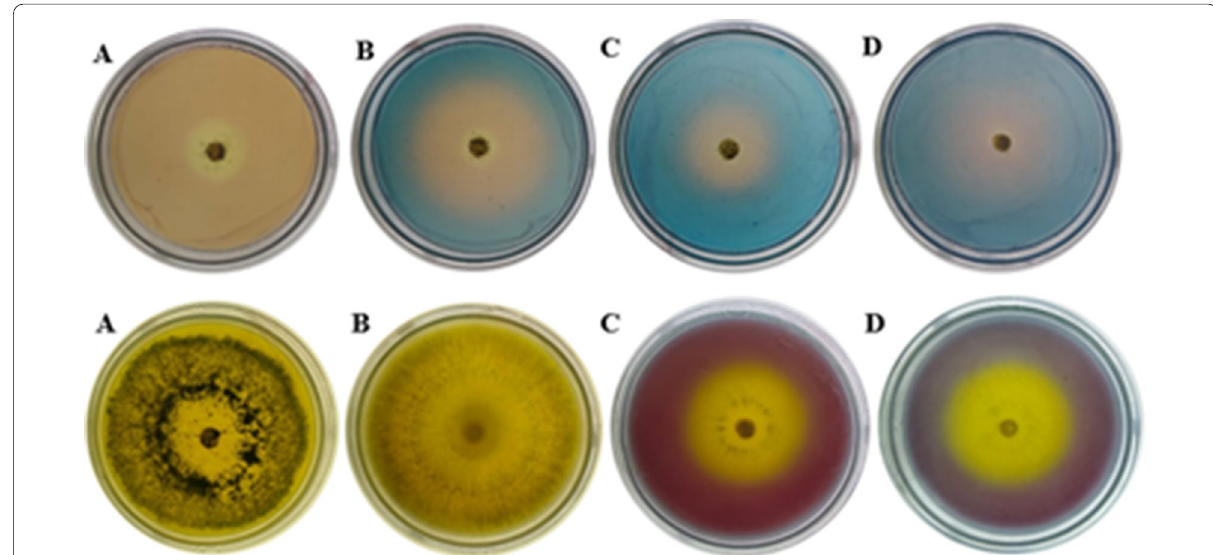
Fig. 4 In vitro plant growth promotion A Trichoderma harzianum , B T. viride , C T. longibrachiatum , D T. asperellum . The first row corresponds to siderophore production; while the second one to phosphate